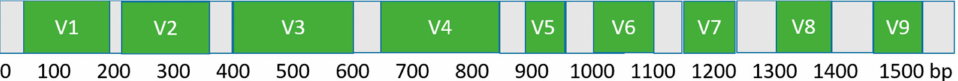
Figure 1. Schematic representation of the bacterial 16S rRNA